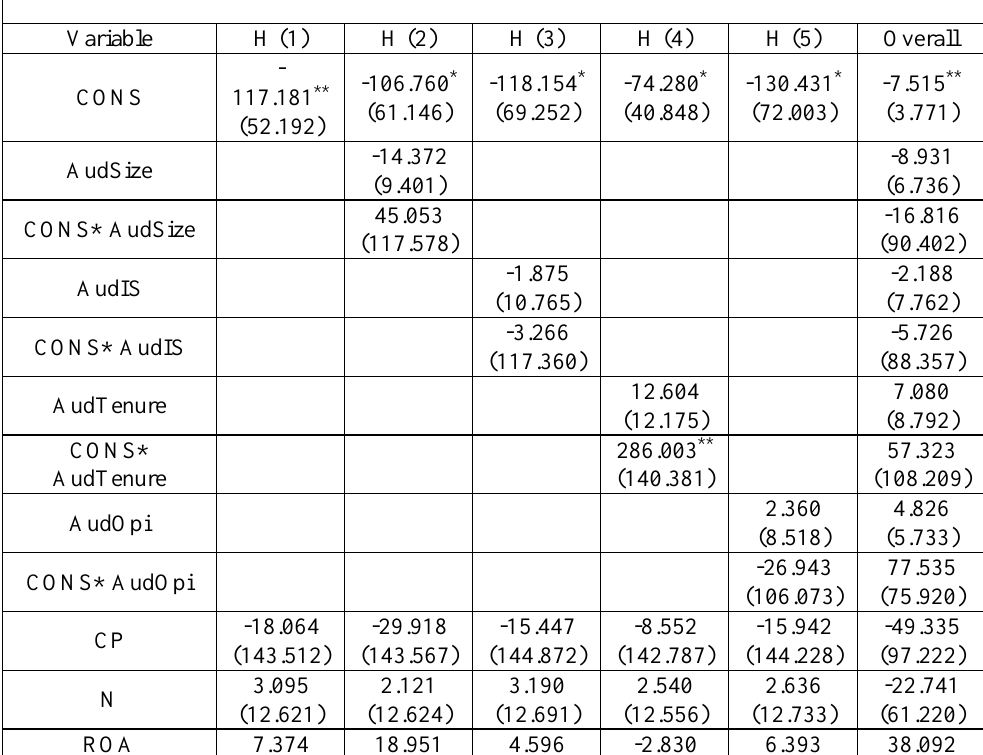
Table 6. Regression result for specified